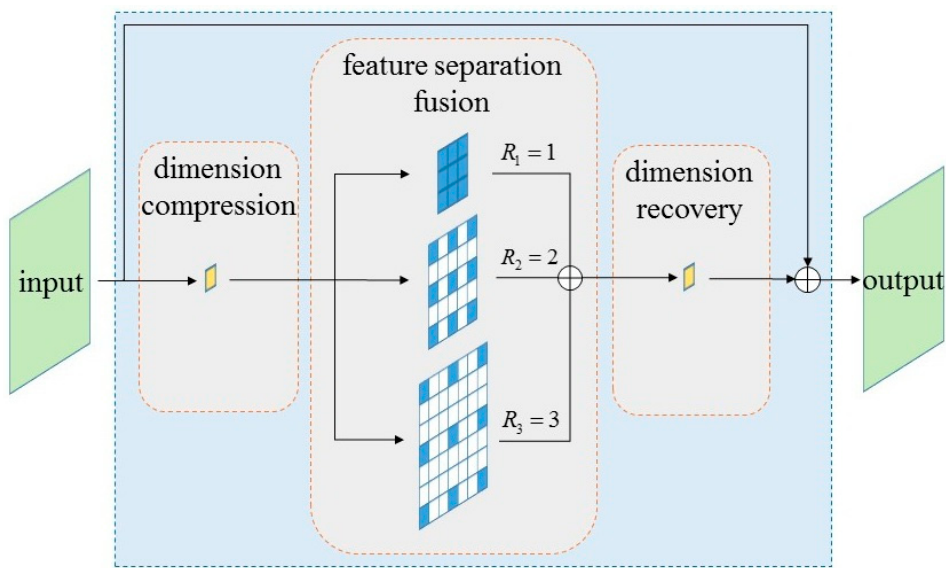
Figure 3. Structure of the multi-scale feature fusion module (MFFM).